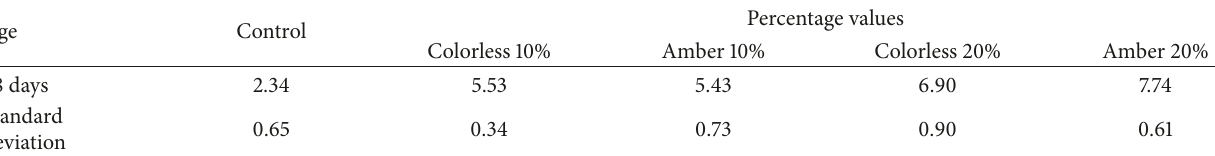
Table 4: Average thickness loss values obtained by abrasion test (1000m).